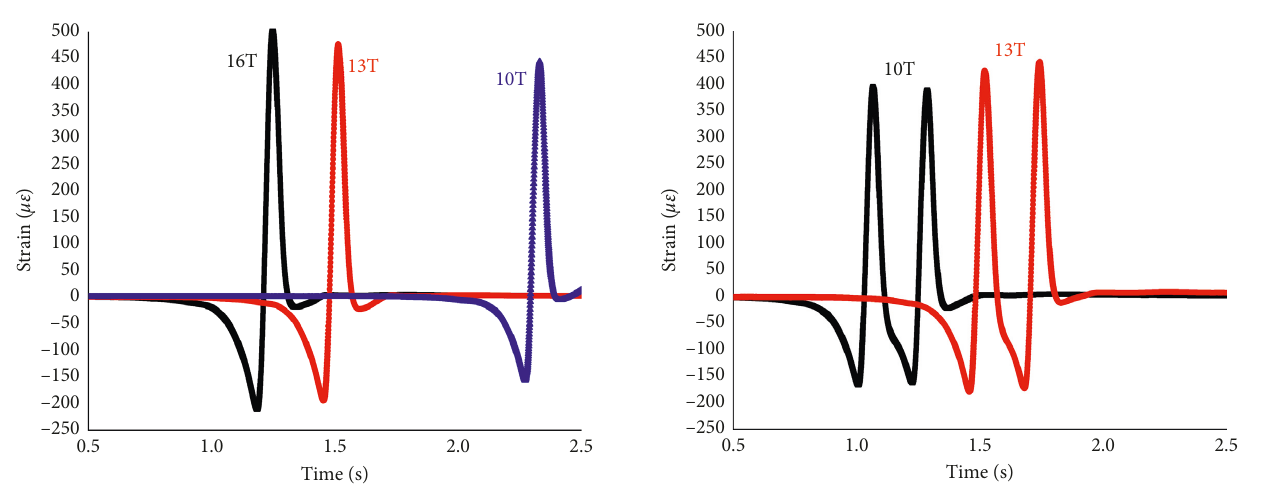
Figure 13: Strain in the single-axle loading mode. Figure 14: Strain in the dual-axle loading